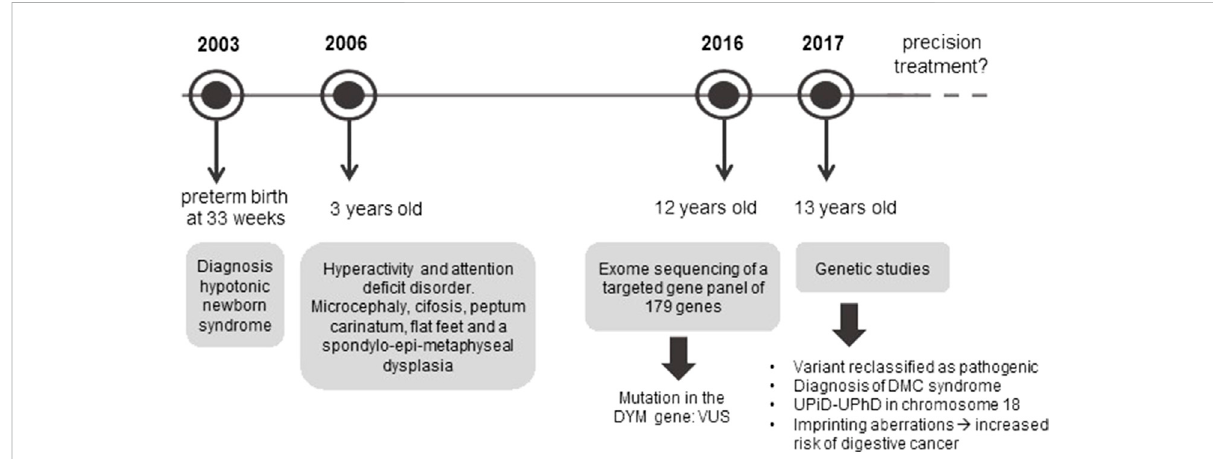
FIGURE 1 Diagnosticodysseytimelineofthepatient.The fi gureshowsthedifferentstagesthatthispatienthasundergonesincetheappearanceofthe fi rst symptoms until a precise diagnosis has been achieved. Once the patient is given a diagnosis, the main challenge is to develop a precision